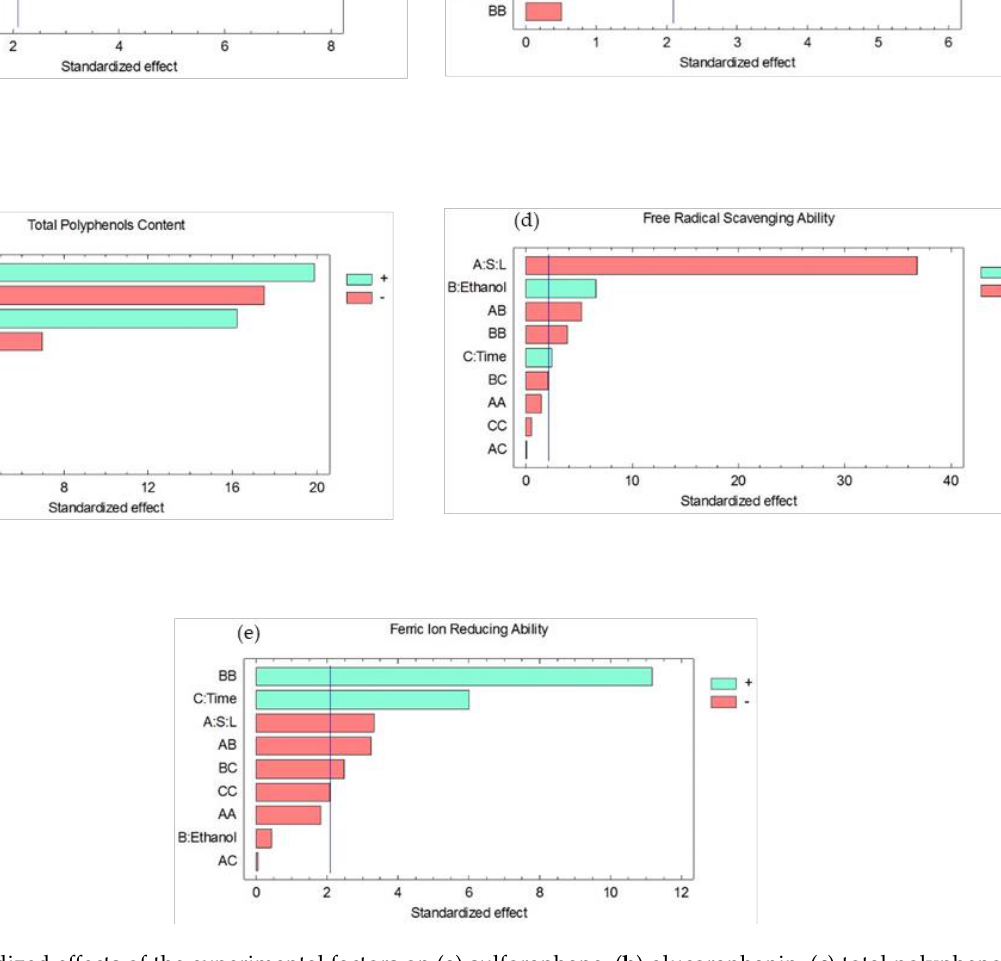
Table 2. Regression models for each response in coded variables. A = solid/liquid ratio; B = ethanol concentration in the extractant solution; C = extraction time. R 2 is the determination coefficient, and R 2 adj is the determination coefficient adjusted by degrees of freedom. SFN is sulforaphane in µg/g dw, GRA is glucoraphanin in µg/g dw, TPP is total polyphe- nols in mg GAE/100 g dw, FRAP is antioxidant activity measured as ferric-ion-reducing ability, and FRSA is antioxidant activity measured as free radical scavenging ability. Models consider only the statistically significant variables. Regression Model